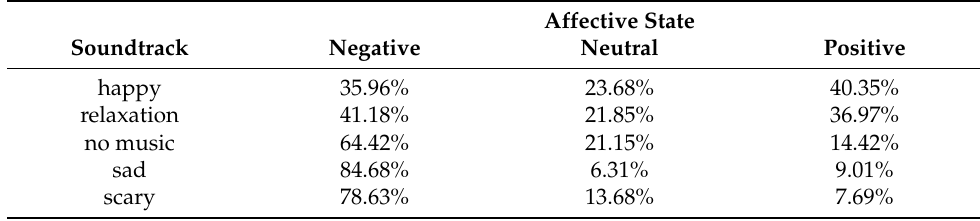
Table 3. Affective states across